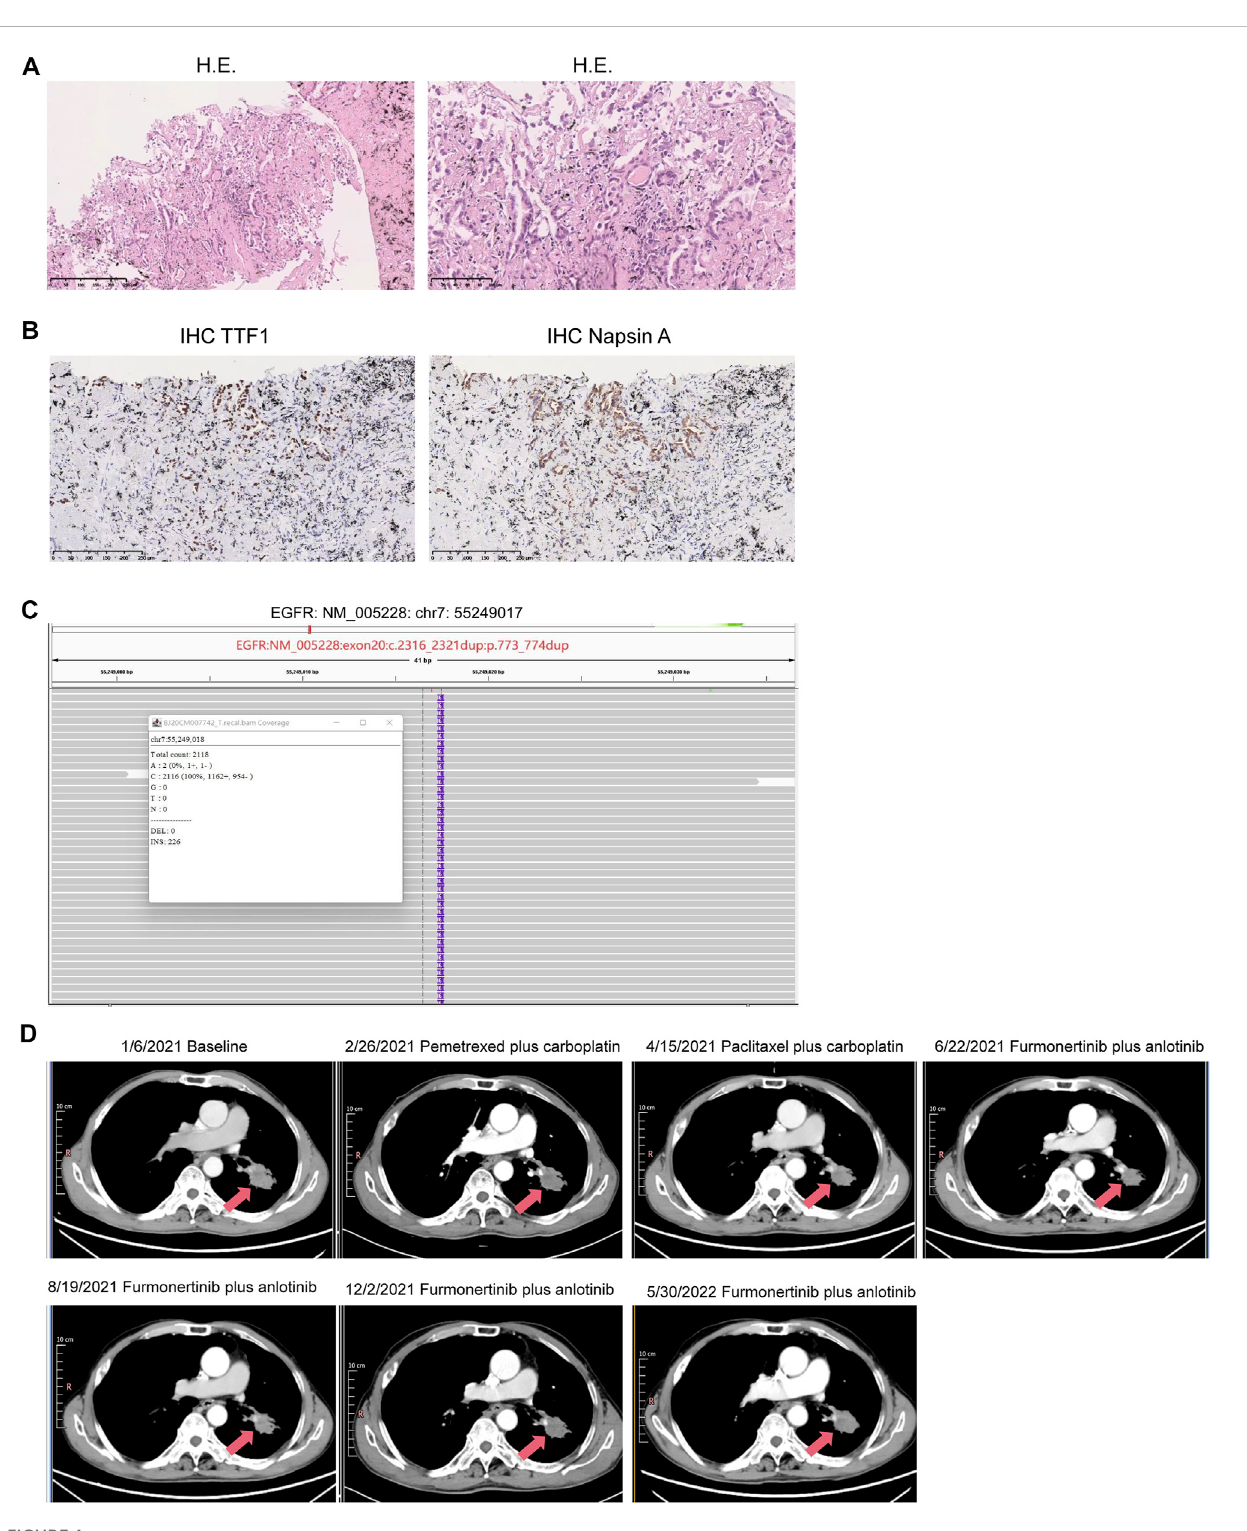
FIGURE 1 Pathology, the sequencing reads of EGFR p.773_774dup, dynamic imaging of the space-occupying lesion on the left lung during the treatment. (A) Pathological fi ndingsrevealedthelesionontheleftlungwasmoderate-differentiatedadenocarcinoma.H.E.:hematoxylin-eosinstaining.Scalebarsrepresent 250 μ m (left) and 100 μ m (right), respectively. (B) Immunohistochemistry (IHC) showed positive expression of thyroid transcription factor 1 (TTF1) and Napsin A.Scalebarsrepresent250 μ m(leftandright). (C) VisualizationofEGFRp.773_774dupmutationusingtheIntegratedGenomicsViewer(IGV)browser. (D) CT images showed that the patient ’ s condition remained stable after receiving furmonertinib plus anlotinib. CT: computed